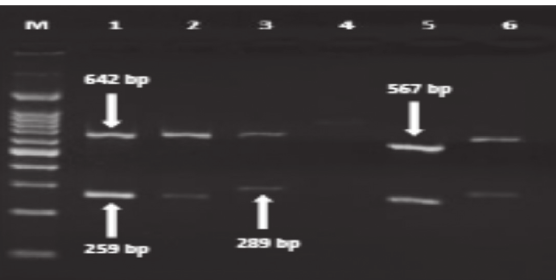
Figure 8: PCR amplification of vacA alleles and cagA: M:100bp ladder; lanes 1–3, 5, and 6: vacA +/ cagA − ; lane 4: vacA − / cagA − ; lane 1: s 1 m 2